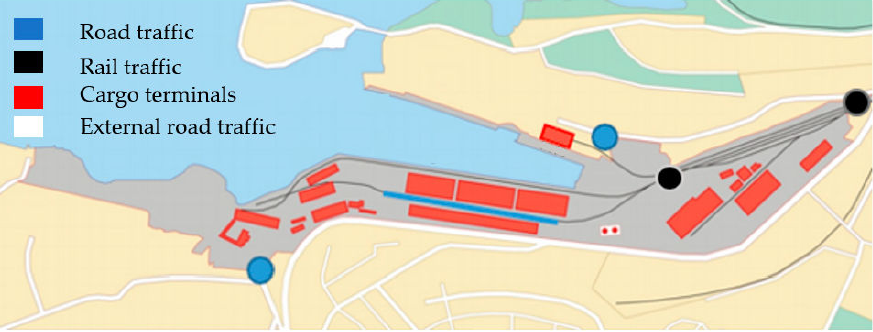
Figure 7. Main noise categories in the research area of Split port ([56],